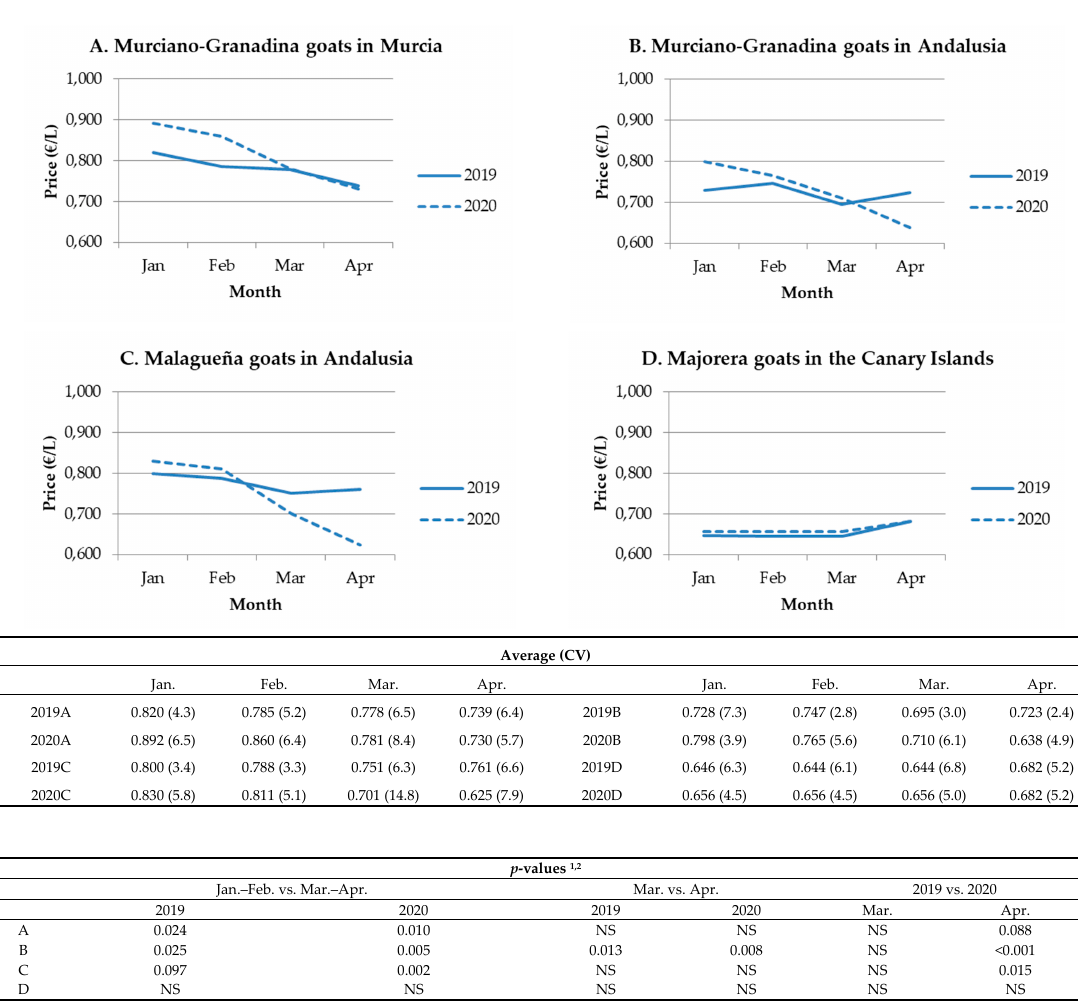
Figure 4. Average monthly price per liter of goat milk (EUR / L) reported by producers from January to April 2019 and 2020 (coe ffi cient of variation, %) according to area and breed, with intra- and interannual comparisons. Data from 20 dairy goat